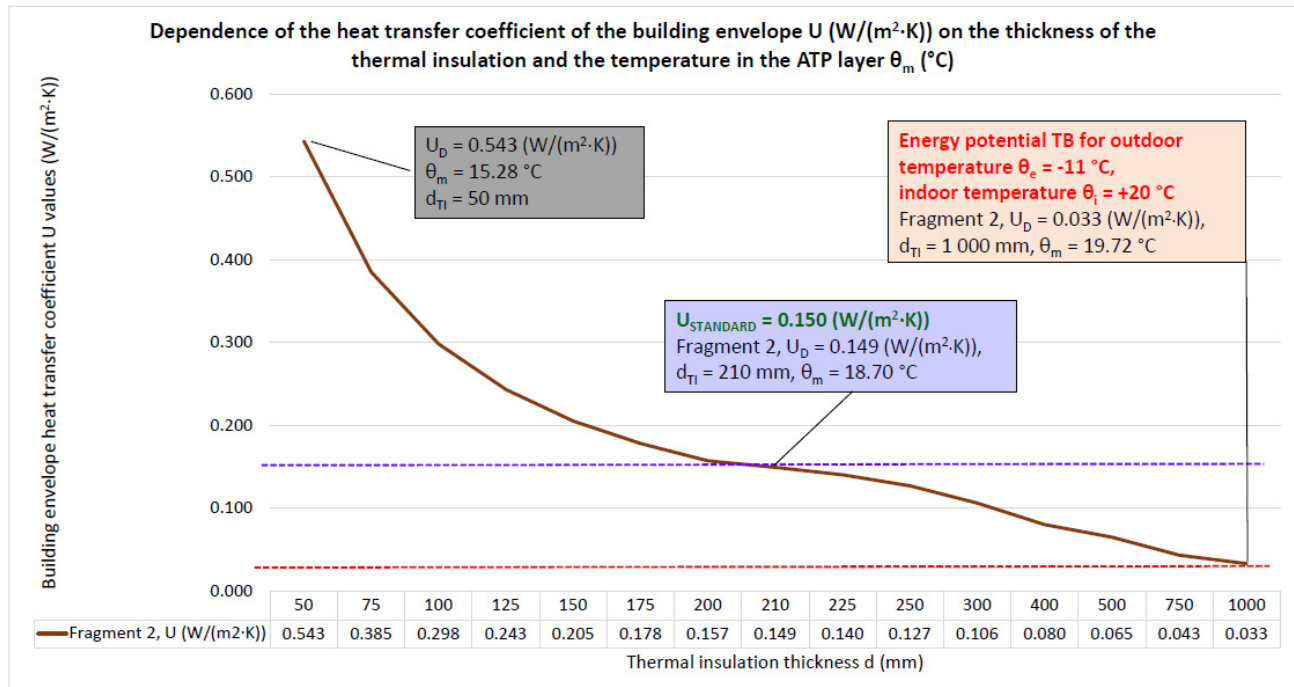
Figure 19. Dependence of the dynamic heat coefficient UD (W/(m2 · K)) on the thickness of the thermal insulation and the mean temperature θ m ( ◦ C) in the ATP layer—Fragment 2.